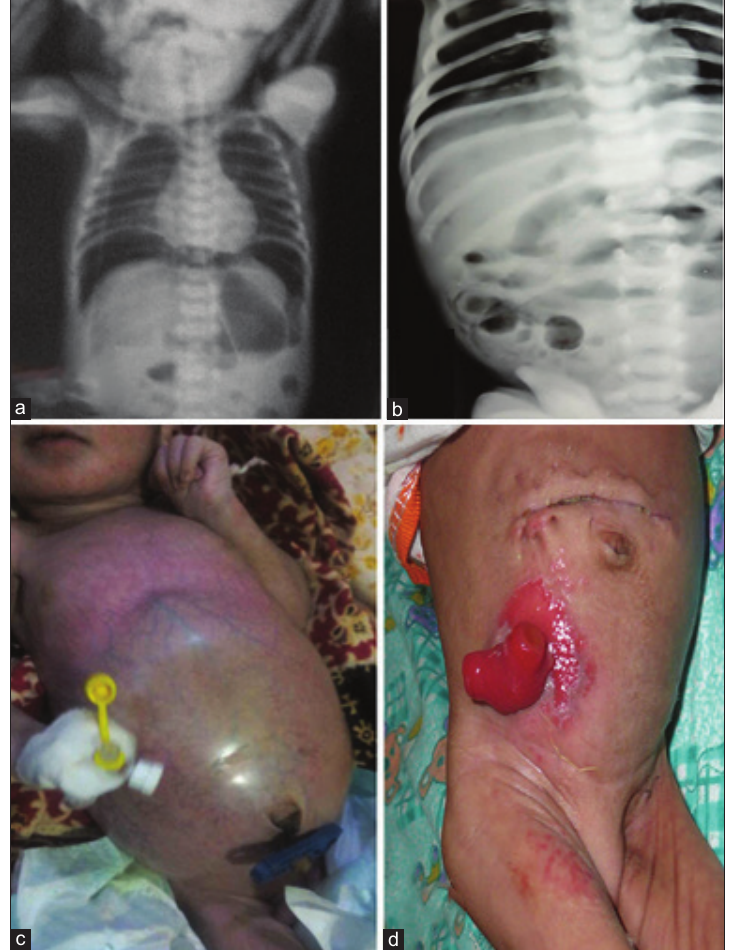
Figure 1: (a) X-ray showing pneumoperitoneum. (b) X-ray showing pneumatosis intestinalis. (c) Clinical photograph showing fixed abdominal mass and erythema. (d) Clinical photograph showing ileostomy